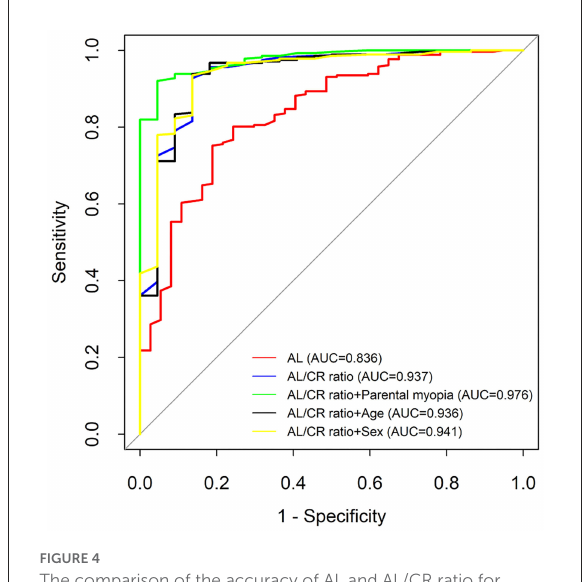
FIGURE4 The comparison of the accuracy of AL and AL/CR ratio for myopia assessment. AL, axial length; AL/CR ratio, axial length/corneal radius ratio; AUC, area under the